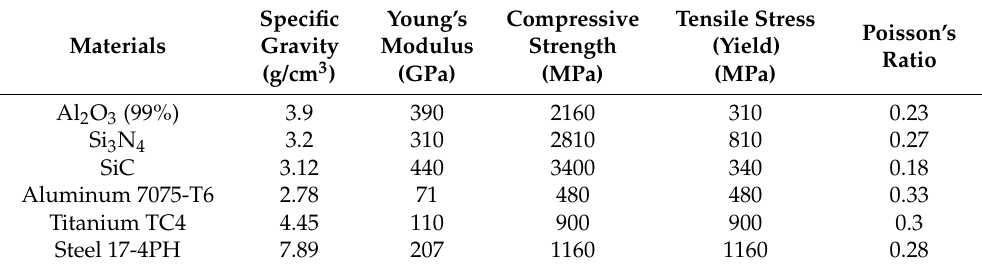
Table 1. Properties of ceramic materials and metal